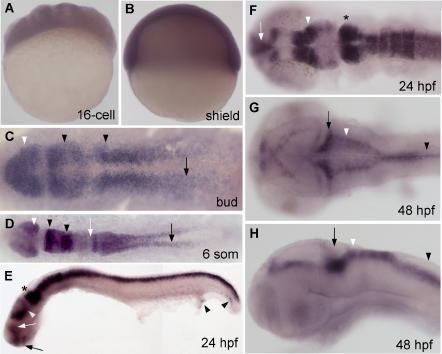
Expression of you Examined by In Situ Hybridization(A and B) Maternal you transcripts were evident in cleavage-stage embryos (A) (16-cell; 1.5 hpf), and you mRNA was widely expressed into the gastrula period (B) (shield stage; 6 hpf). In addition, you mRNA was detectable by RT-PCR at 2 hpf, prior to the zebrafish midblastula transition.(C) Toward the end of gastrulation, you transcripts began to be restricted, so that at the bud stage (10 hpf), you expression was evident in the eye field (white arrowhead), in the developing midbrain and hindbrain (black arrowheads), and in posterior paraxial stripes (arrow).(D) During early somitogenesis (12 hpf), you expression was observed in the eye field (white arrowhead), in stripes in the midbrain and the MHB (black arrowheads), in a complex pattern in the hindbrain (white arrow), and in paraxial stripes along the developing trunk and tail bud (black arrow).(E and F) At 24 hpf, you transcripts were observed dorsal to the hypothalamus (black arrow), at the boundary between the telencephalon and the diencephalon (white arrow), in the ventral tectum (white arrowhead), in the region of the presumptive cerebellum (asterisk), and dorsally along the length of the spinal cord. Additional expression of you at this stage and later was observed in the ventral tail and at the urogenital opening (arrowheads; data not shown).(G and H) At 48 hpf, you transcripts were highly expressed in the cerebellum (black arrow), and were also present in the rhombic lip (white arrowhead), and continuing along the length of the anterior–posterior axis in the dorsal spinal cord (black arrowhead; data not shown).Orientation of images: (A) lateral view; (B) lateral view, dorsal to the right; (C, D, F, and G) dorsal views, anterior to the left; (E and H) lateral views, anterior to the left.